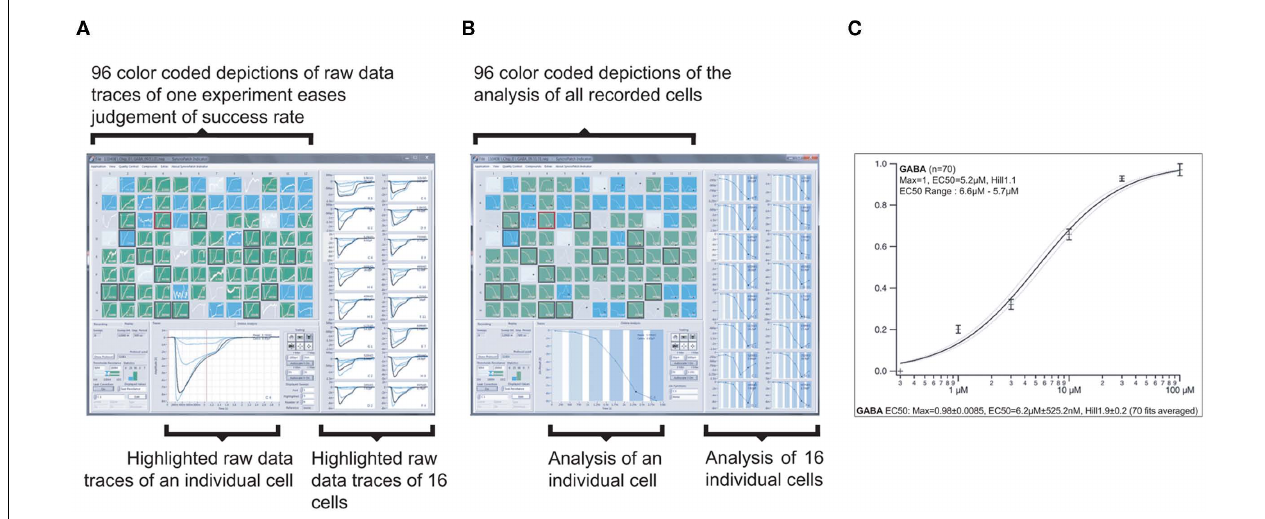
FIGURE 11 | Graphical user interface of the screening and data analysis software used on the SyncroPatch 96. (A) Screenshot of depiction of raw data of GABA A subunits α 1 β 2 γ 2 expressing HEK cells as recorded on one NPC-96 patch clamp chip. Ninety-six small color coded pictures as seen in the upper left part display all 96 parallel recordings. Depending on the seal resistance, pictures are green ( R memb > 100M Ω ), blue ( R memb = 50–100M Ω ), light blue or gray ( R memb < 50M Ω or no cell capture). One highlighted experiment is displayed below, 16 other selected experiments are displayed on the right.Traces show currents of individual cells which were activated by